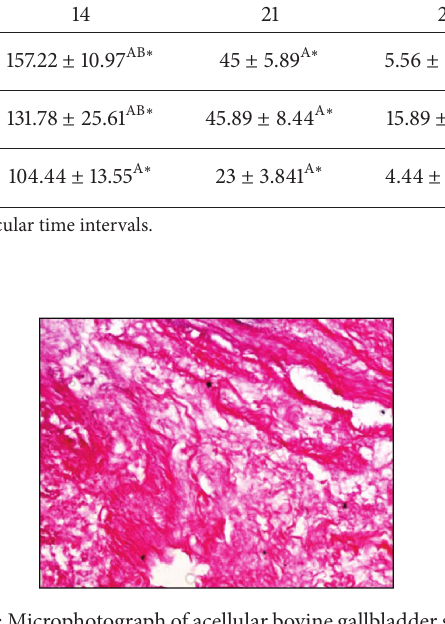
Figure 3: Microphotograph of acellular bovine gallbladder showing complete loss of cellularity (H&E stain, 200x).